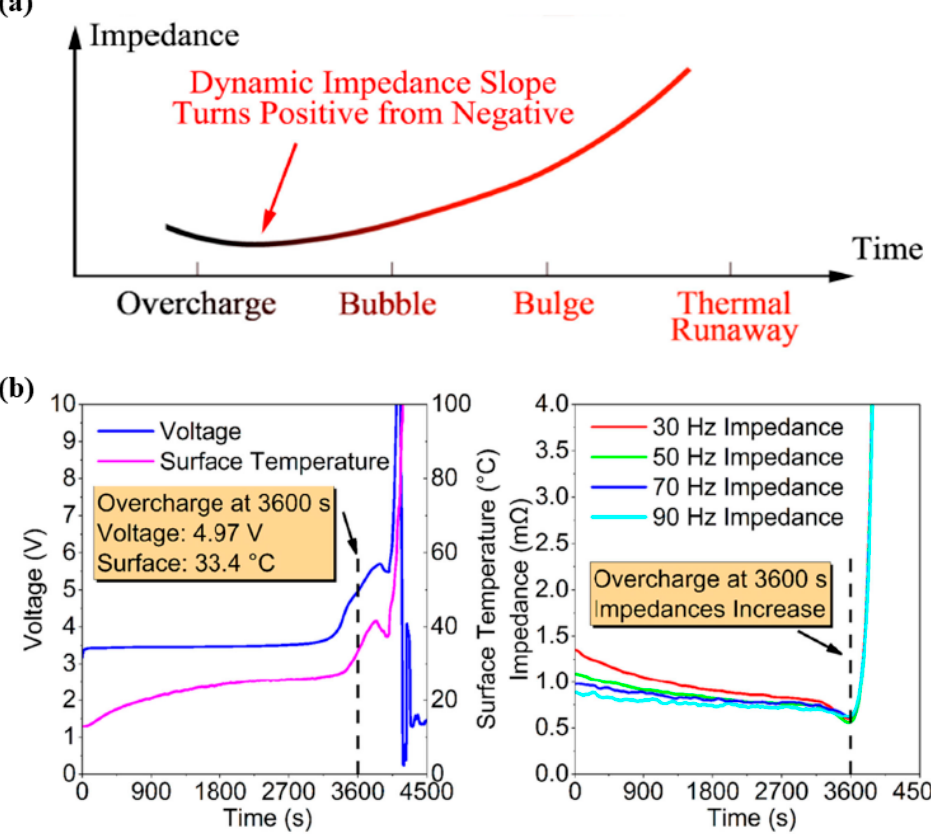
Figure 8. Through the real-time dynamic impedance to detect TR: ( a ) real-time dynamic impedance slope change during battery overcharge [95]; ( b ) the inflection points of impedance, voltage, and temperature [95].